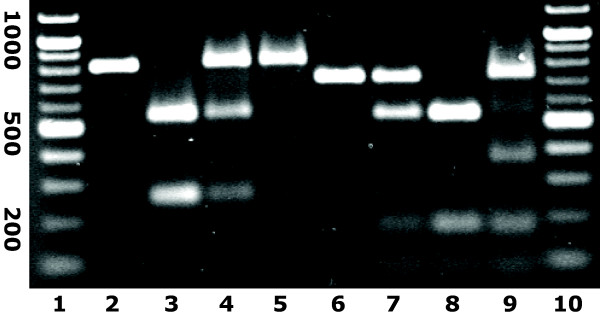
Restriction pattern by Eci-1 and MspA1 l fragmentation of the uPAR promoter sequence. Lane 1 and 10, 100 bp-marker; lane 2 non digested PCR-product, lane 3–5 Eci-1 fragmentation of the -118 G to A transition (G/G; G/A and A/A), lane 6–8 MspA1 l fragmentation of the -465 A to G transition (A/A; A/G and G/G); lane 9 Eci-1 and MspA1 l fragmentation of a double heterozygote individual.